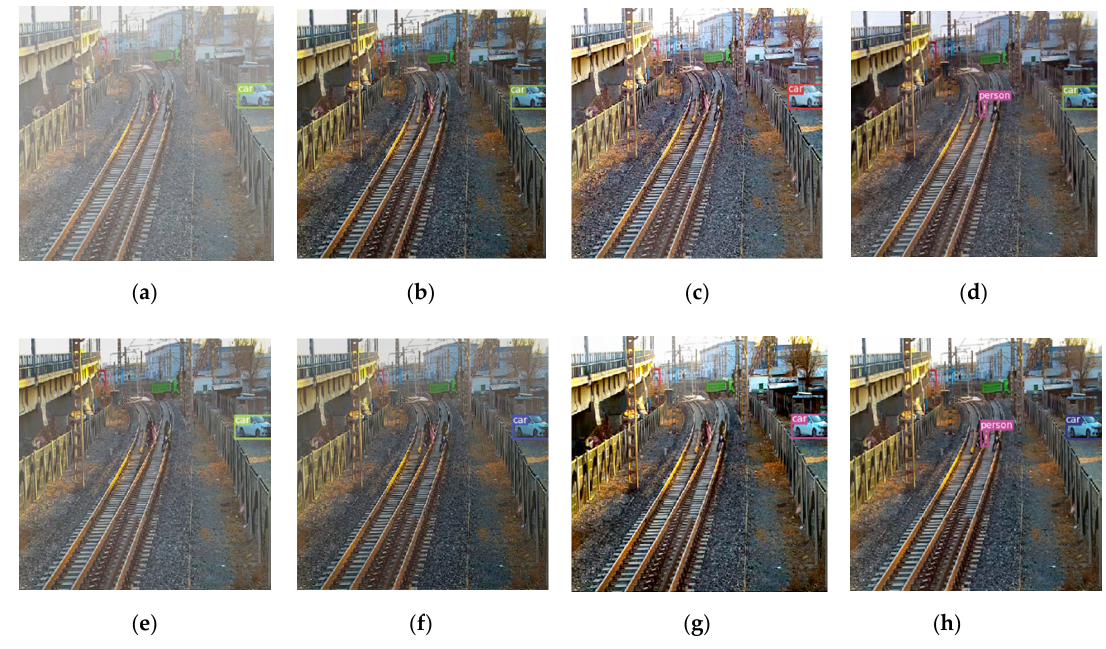
Figure 8. Zooming in on a group of detection results from Figure 7. The same input image is dehazed by different algorithms, and then detected by YOLOV3. It can be seen that only our algorithm detects people on the track. ( a ) Hazy images + YOLOv3, ( b ) He et al. [7] + YOLOv3, ( c ) Berman et al. [32] + YOLOv3, ( d ) Chen et al. [13] + YOLOv3, ( e ) Ren et al. [10] + YOLOv3, ( f ) Li et al. [11] + YOLOv3, ( g ) Zhang et al. [33] + YOLOv3, ( h ) Ours + YOLOv3.